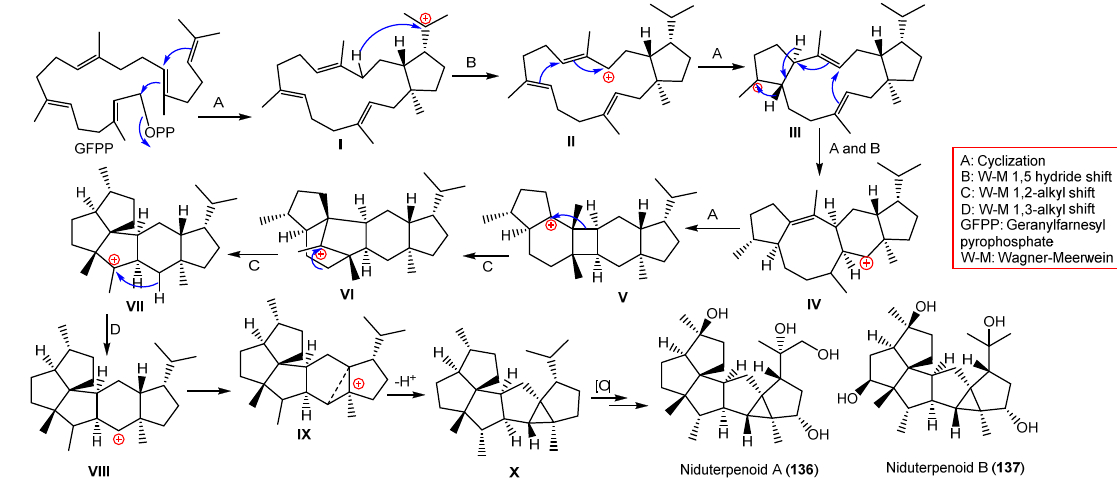
Figure 15. Structures of terpenoids ( 135 – 144 ).